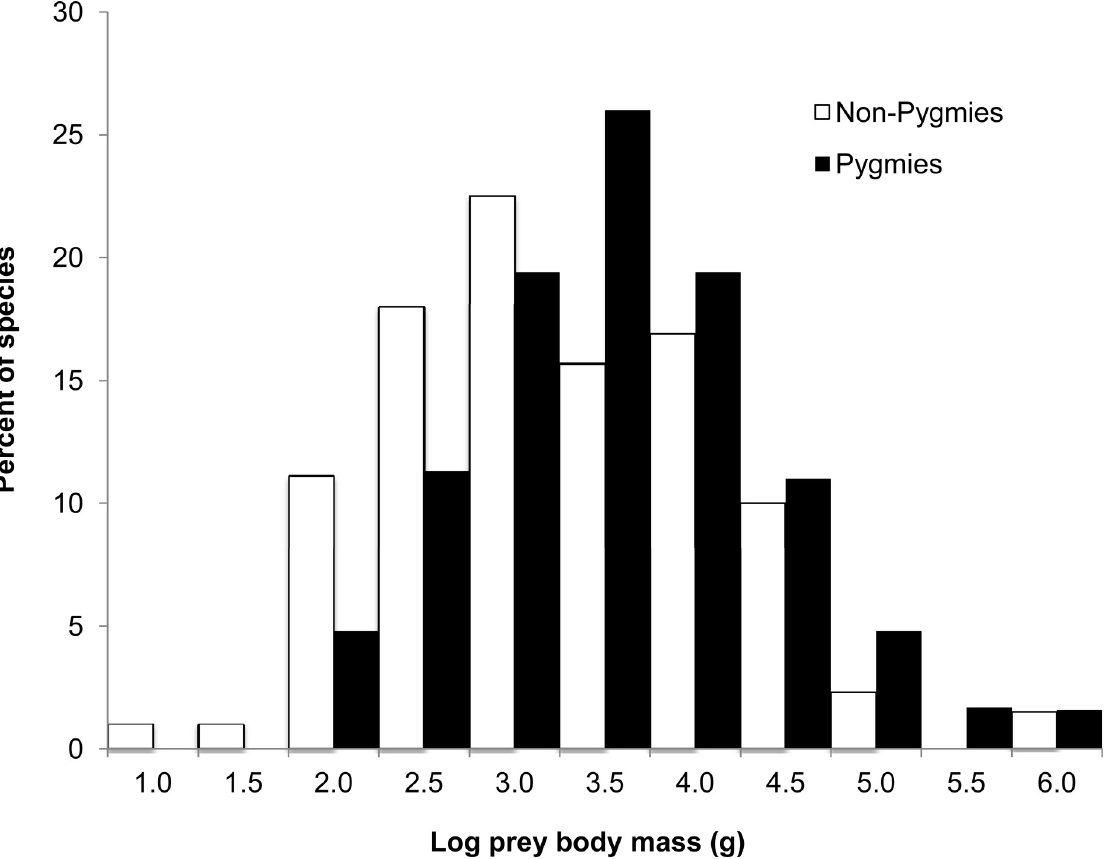
Fig 3. Size distribution of forest vertebrate kills harvested by Pygmies (n = 34 studies) and Non-Pygmies (n = 26), in terms of the (log 10 -transformed) body mass (in grams) of all recorded whole carcasses (adults and juveniles) of animal species (Pygmies = 71 spp.; Non-Pygmies = 122 spp.) hunted by each hunter